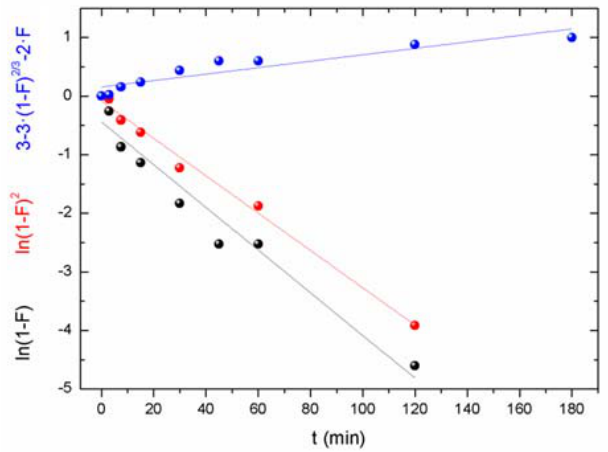
Figure 9. Adsorption mechanisms of Pb 2+ on activated carbon.